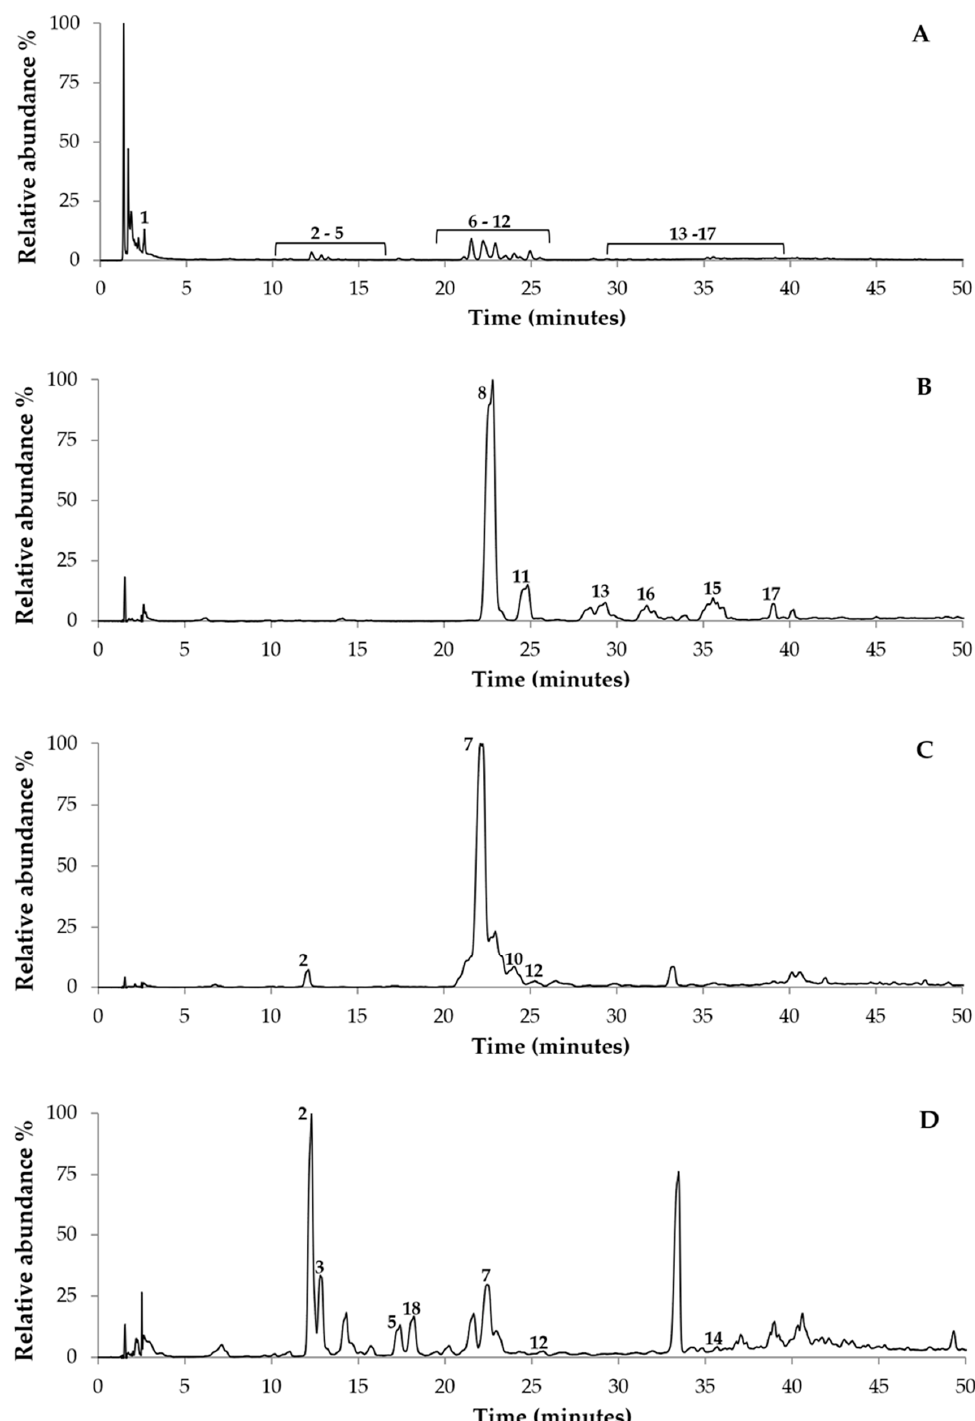
Figure 4. Chromatographic profile of ( A ) G18.EE- n -BuOH; ( B ) subfraction E; ( C ) subfraction I, and ( D ) subfraction K obtained by UHPLC-DAD-ESI/MS n (280 nm). Each peak numbered in the figure represents a different compound identified in Table 2.